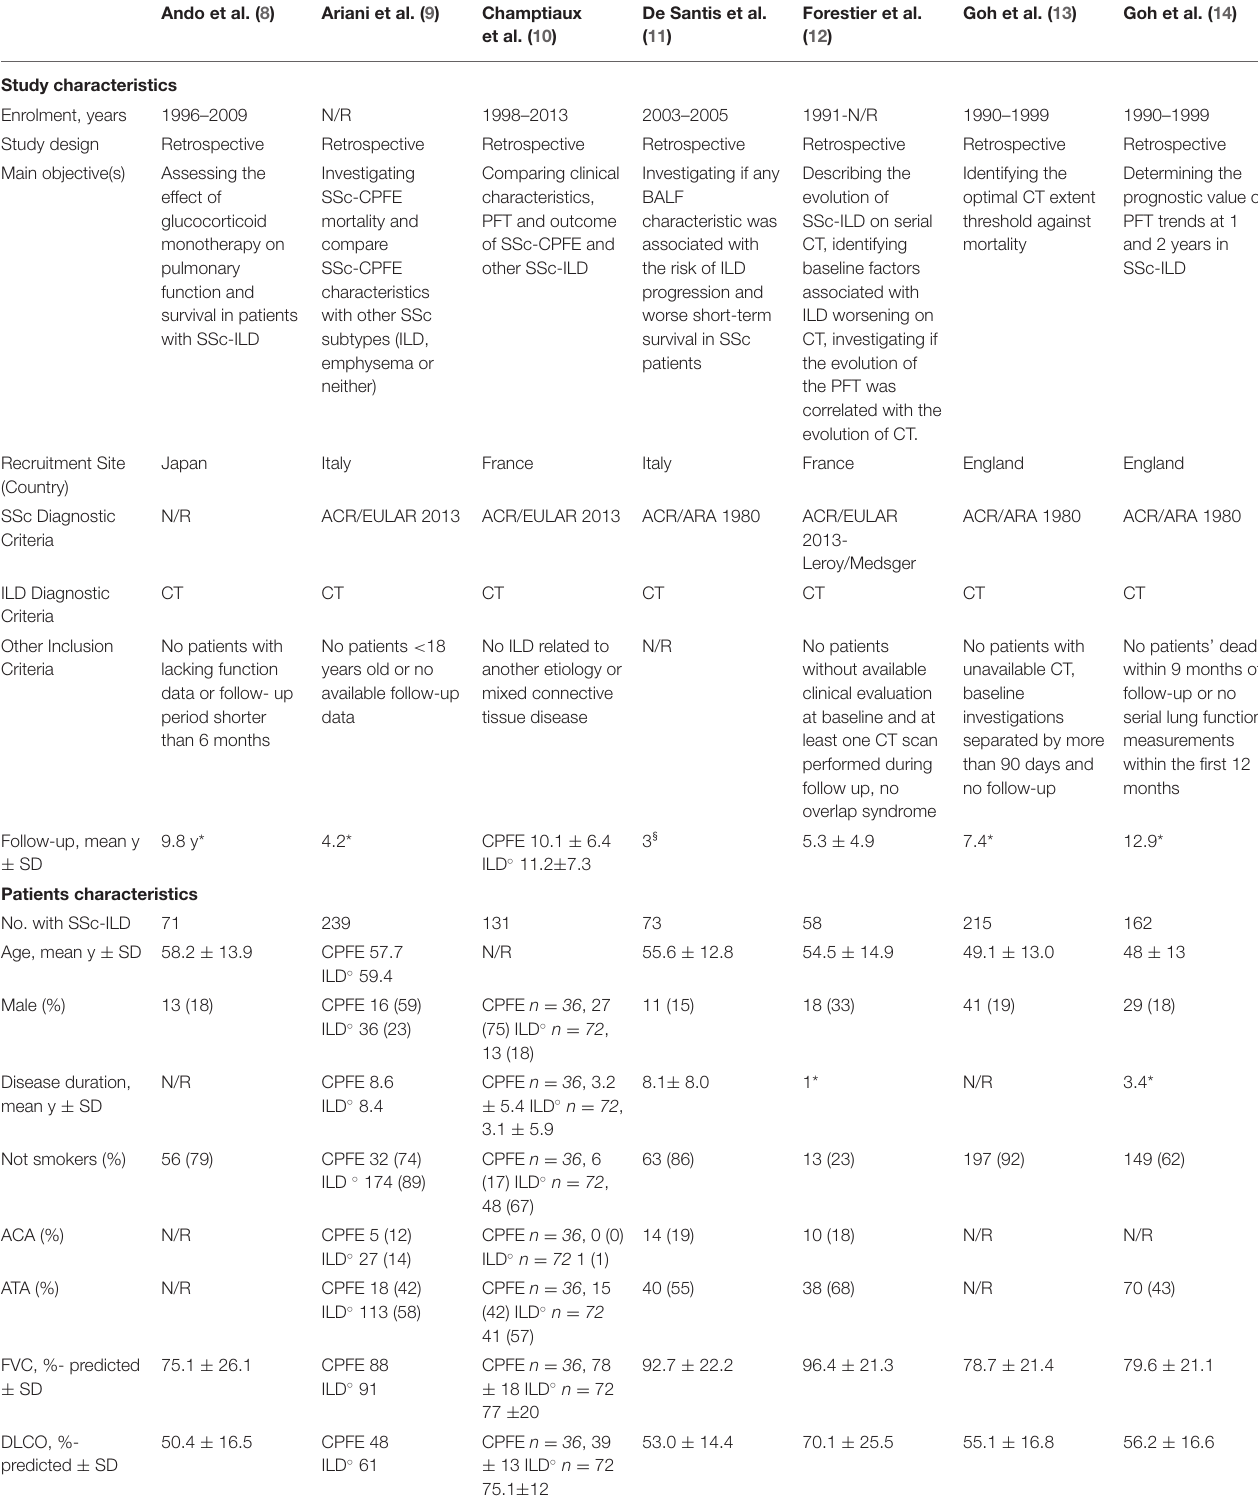
TABLE 1 | Studies and patients